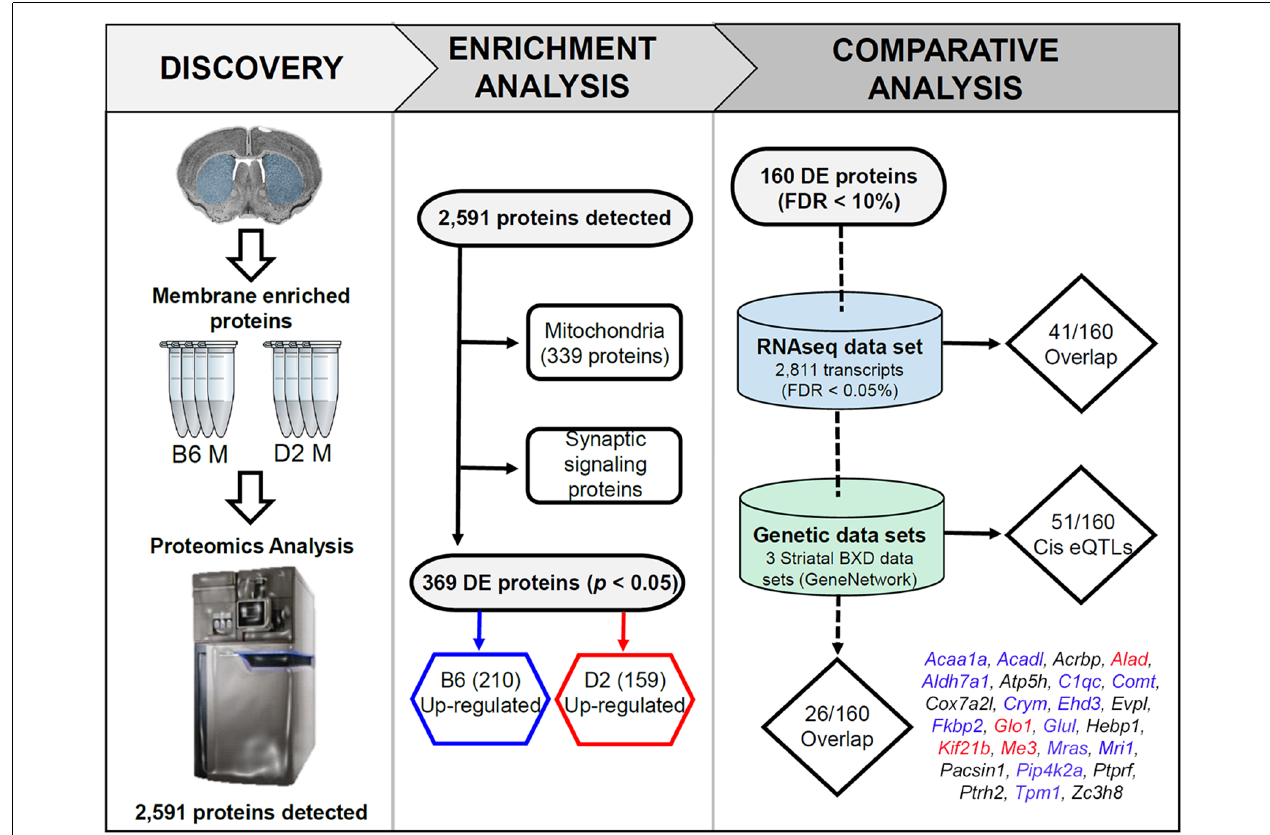
FIGURE 1 | Overview of the discovery, enrichment, and comparative analyses. In the discovery phase, membrane and mitochondrial enriched protein fractions were collected from the striatum (dorsal and ventral) of four males from the B6 and D2 inbred mouse strains. For the enrichment analysis, all detected proteins were first queried for enrichment of functional terms using the ENRICHR web service. This resulted in detection of 339 mitochondrial genes. The remaining proteins were found to be enriched for synaptic signaling pathways (summarized in Figure 2 ). In the last phase of enrichment analysis, 369 differentially expressed (DE) proteins were divided into two groups for additional enrichment analysis based on higher expression in the B6 or D2 strain. The results of this analysis can be found in Figure 3 . For comparative and genetic analysis the top 160 DE proteins based on a 10% FDR were compared against two related data sets. The first data set consisted of striatal gene expression profiled in male B6 and D2 mice by RNA-seq. The second data set included expression quantitative trait loci (eQTL) mapping in three different striatal expression data sets from a recombinant inbred progeny—the BXD population—derived from the B6 and D2 strains. The final list of 26 proteins with differential mRNA expression and evidence of genetic regulation of gene expression in the BXD panel is shown above (blue, red, and black text indicates higher expression of the B6 allele, D2 allele, or a mixture of both across the three data sets, respectively). A summary of the overlap analysis can be found in Supplementary Table S3